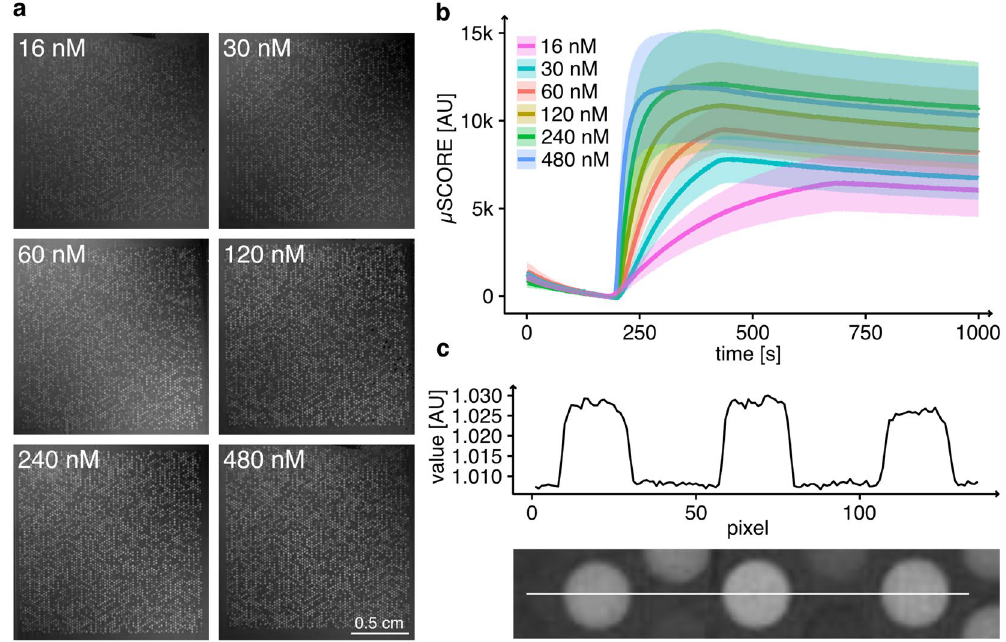
Figure 2. ( a ) highSCORE images illustrating the total binding of TCR against the pHLA spots of the microarray for different concentrations of analyte. The brighter the spots are, the more TCER molecules bound to the spots. Every image originates from an individual highSCORE measurement. A small area of crosscontamination is visible in the upper left corner of 240 nM image (at the image label). Small areas like this are not critical for the evaluation of the bindng kinetic values since a high number of replicates (n=26) was randomly distributed over the array for each peptide-HLA combination.( b ) highSCORE binding curves of the TCER binding to its WT peptide (SLLQHLIGL). The curves are illustrated as mean curves with sd error bands (n=26 per binding curve). The association time was increased for the 16 nM concentration. ( c ) Line scan over 3 spots of the 480 nM microarray. The graph illustrates the gray pixel values of the white line in the image